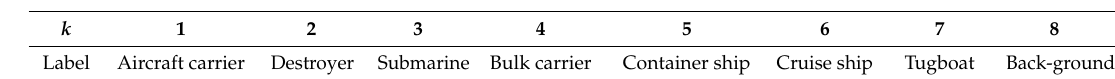
Table 1. Classes in the ship dataset.